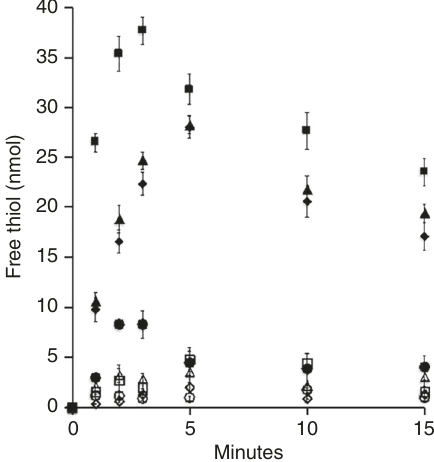
Fig. 3 Reverse methyltransferase activity in the direction of CH 3 - tetrahydrofolate production driven by a sodium gradient dependent on reduced ferredoxin:Fe(III) oxidoreductase activity. The standard reaction mixture (1.0 ml) contained Fe(III)-loaded vesicles (1.0 mg protein), 2.0 mM CH 3 -SCoM (methyl-coenzyme M), 2.0 mM THF (tetrahydrofolate), 5.0 µ M Fdx (ferredoxin), 25 mM MgSO 4 , 0.4 M sucrose and 0.5 mM residual NaCl in 20 mM Tris (pH 7.0) and 1.0 atmosphere of CO. Reactions were initiated mixture ( fi lled diamonds), plus 1 mM ATP ( fi lled squares), plus 10 µ M carbonyl cyanide m -chlorophenyl hydrazine (CCCP) ( fi lled triangles),